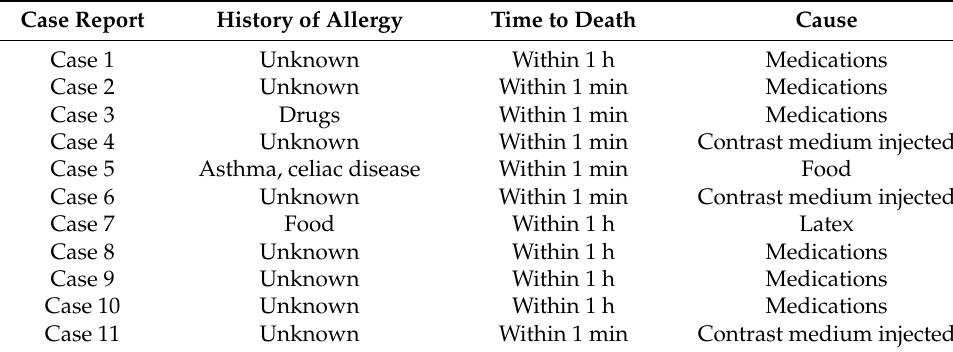
Table 1. The circumstantial data of the selected